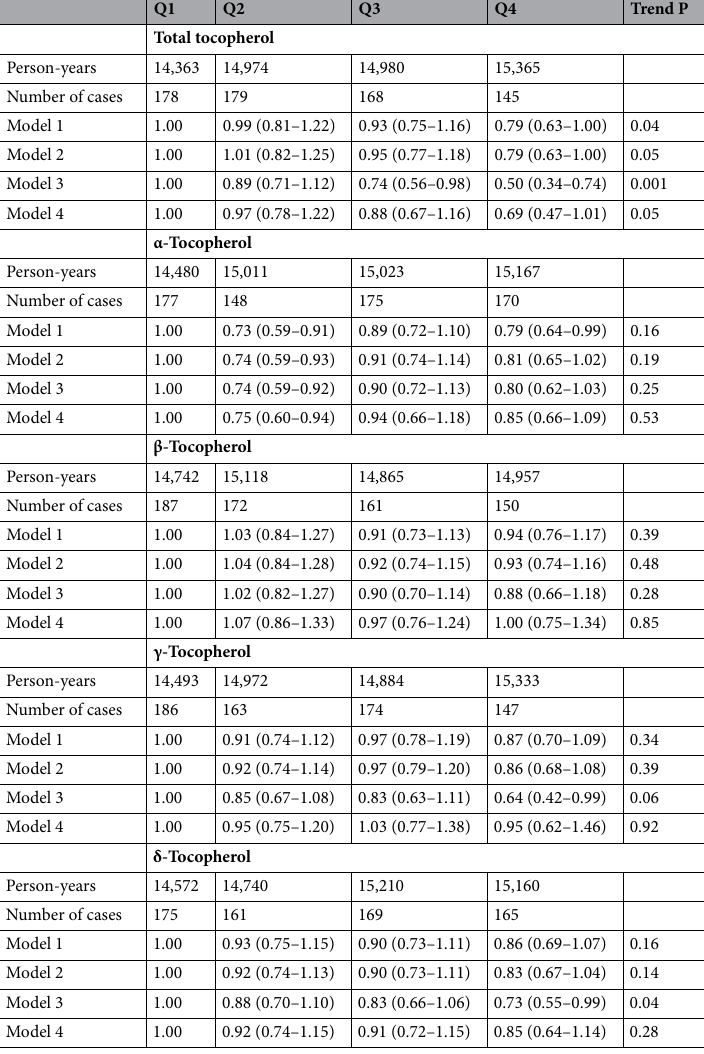
Table 2. Multivariable hazard ratios and 95% confidence intervals of disability dementia according to quartiles of total tocopherol, α-, β-, γ- and δ-tocopherol intakes. Model 1: Adjusted for age and sex, and stratified by area. Model 2: Multivariable model adjusted further for energy, smoking status, and DHA + EPA. Model 3: Multivariable model adjusted further for variables in model 2 and α-linolenic acid. Model 4: Multivariable model adjusted further for variables in model 2 and linoleic